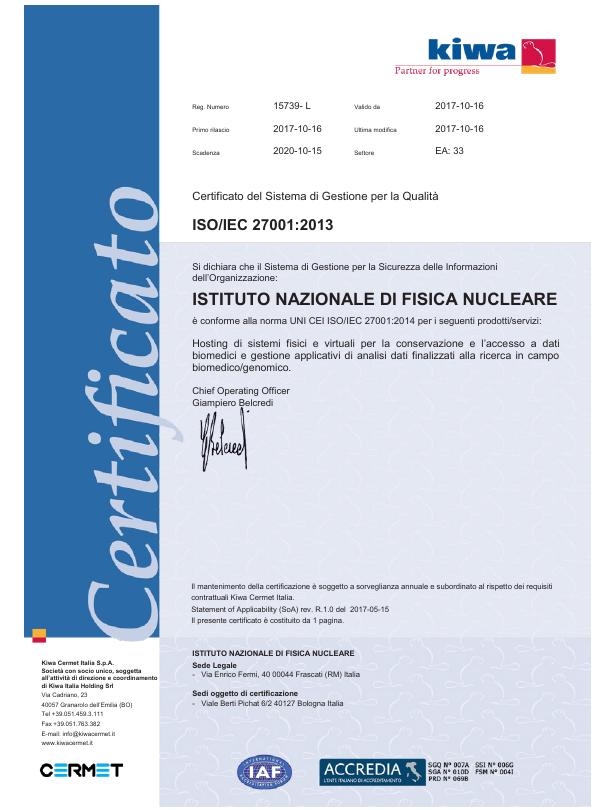
Figure 2: ISO 27001